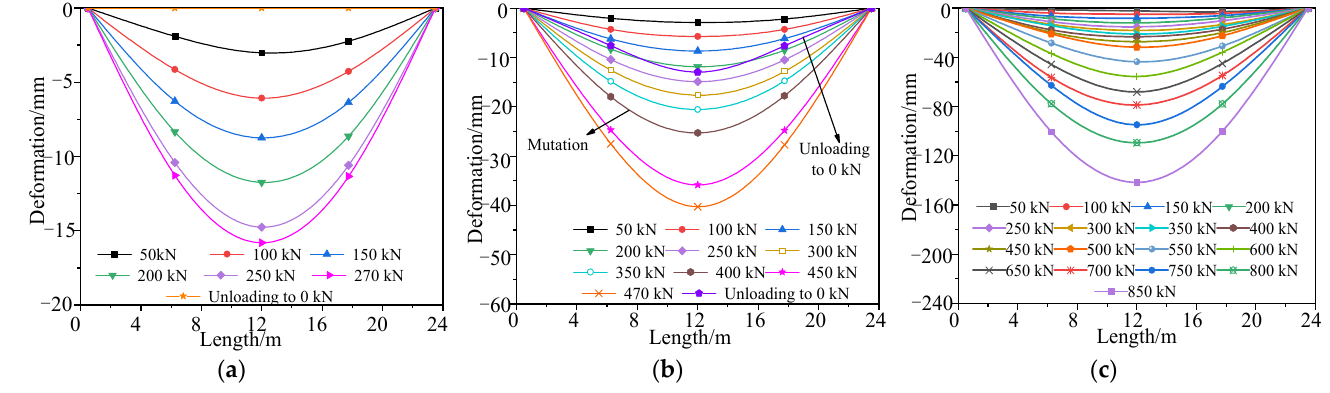
Figure 11. Deformation curve of the undamaged test box girder bottom plate. ( a ) First cycle of loading and unloading; ( b ) Second cycle of loading and unloading; ( c ) Third loading to failure. According to the failure test, the strain vs. load curves under each load stage were obtained, as shown in Figures 12 and 13. Figure 12 shows that the inflection points of the strain vs. load curves appeared due to cracks when the load reached 362 kN, and the concrete strain of the right web was slightly larger than that of the left web at the same load stage. Since the section of the test box girder was not completely symmetric, the height of the left web was larger than that of the right web. Figure 13 shows that the strain of